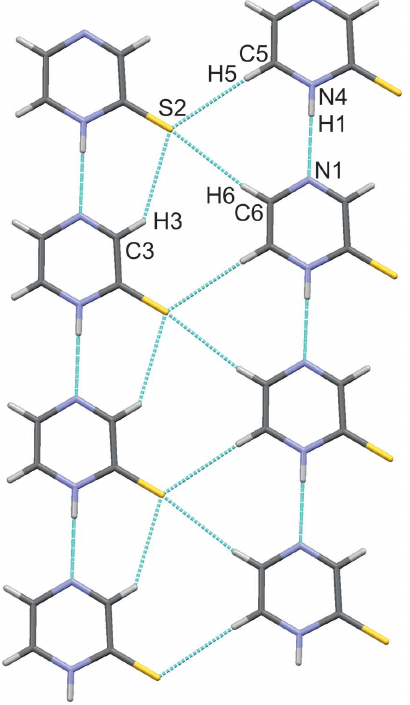
Table 1 Hydrogen-bond geometry (A˚ , (cid:5) ).